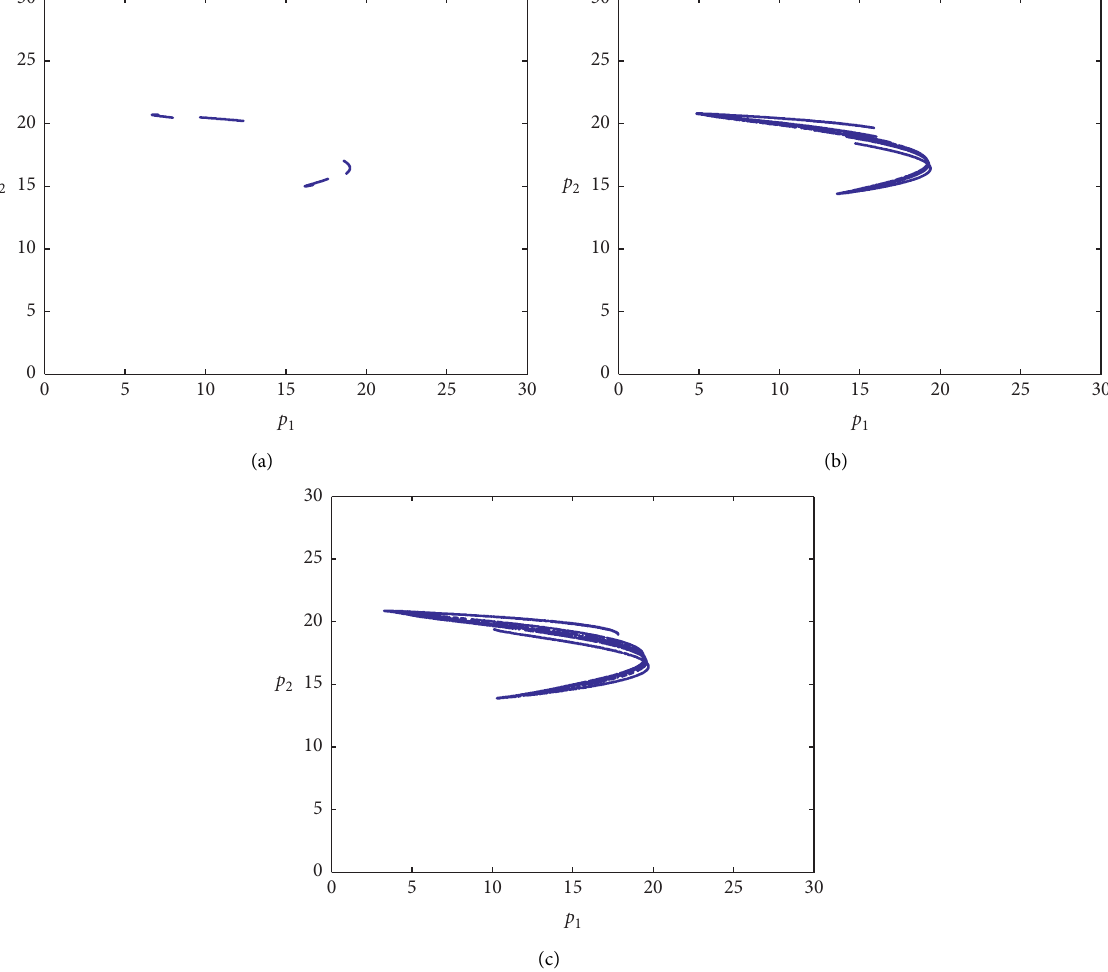
Figure 11: The chaotic attractor of dynamic system (15). (a) δ